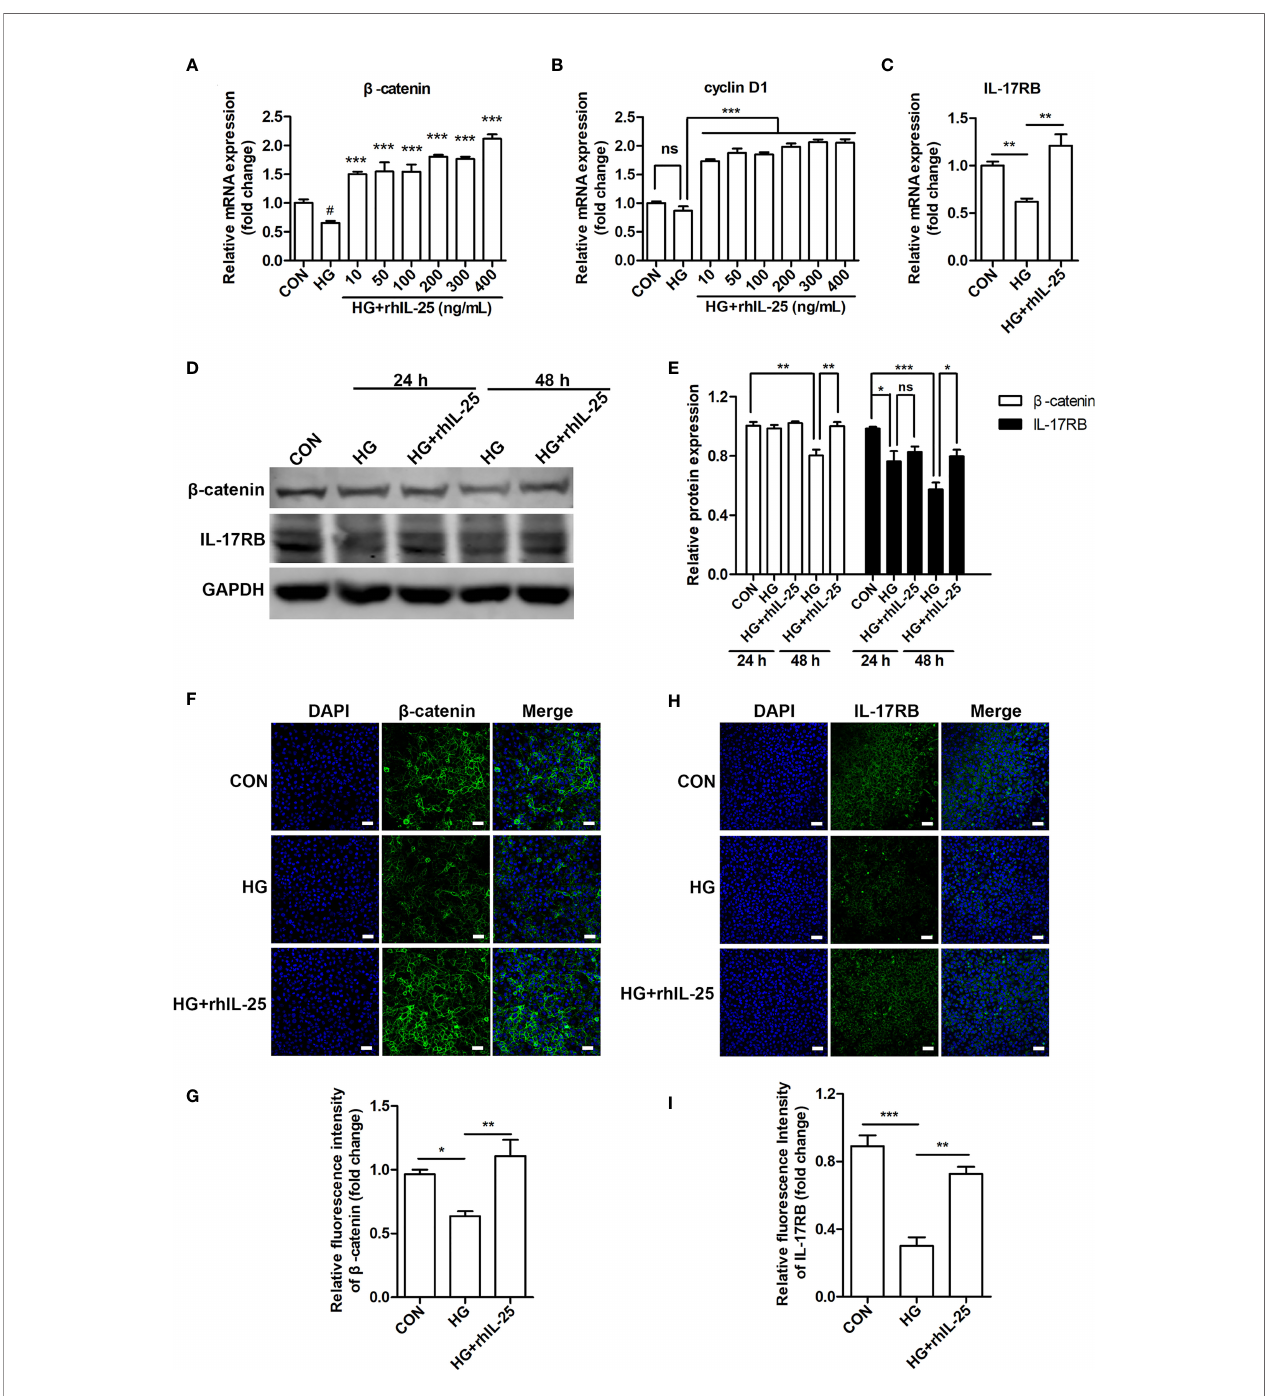
FIGURE 6 | IL-25 rescues the inactivation of Wnt/ b -catenin pathway in vitro . (A, B) HUVECs were stimulated with increasing concentrations of rhIL-25 for 48 h under high glucose conditions (HG). b -catenin and cyclin D1 mRNA from untreated HUVEC and rhIL-25-treated HUVECs under HG conditions were analyzed by qPCR analysis (n = 3). (C) IL-17RB mRNA expression in HUVECs stimulated with 400 ng/mL rhIL-25 under HG conditions for 48 h (n = 3). (D, E) Western blotting analysis of b -catenin and IL-17RB and their quanti fi cation (n = 3). (F – I) Representative immuno fl uorescent staining images and quanti fi cation of b -catenin (F, G) and IL-17RB (H, I) in HUVECs exposed to high glucose and high glucose with rhIL-25 conditions for 48 h (n = 3). Scale bars, 60 m m. * and # P < 0.05, ** P < 0.01, *** P < 0.001 ( # compared with CON group, *compared with HG group). ns, no signi fi